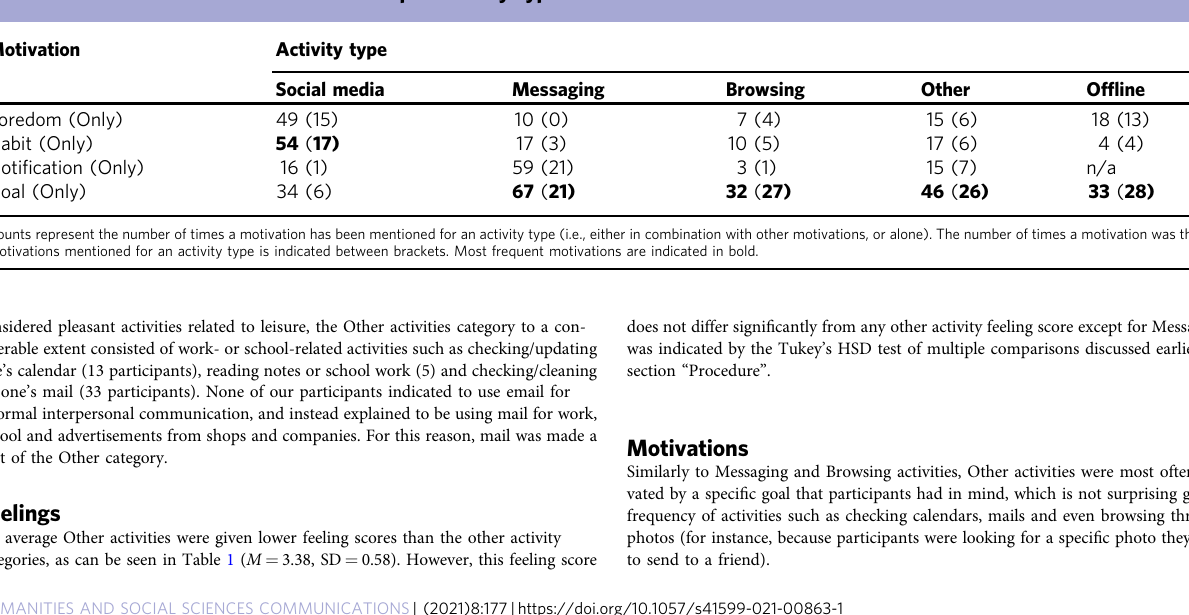
Table 3 Counts of motivations mentioned per activity